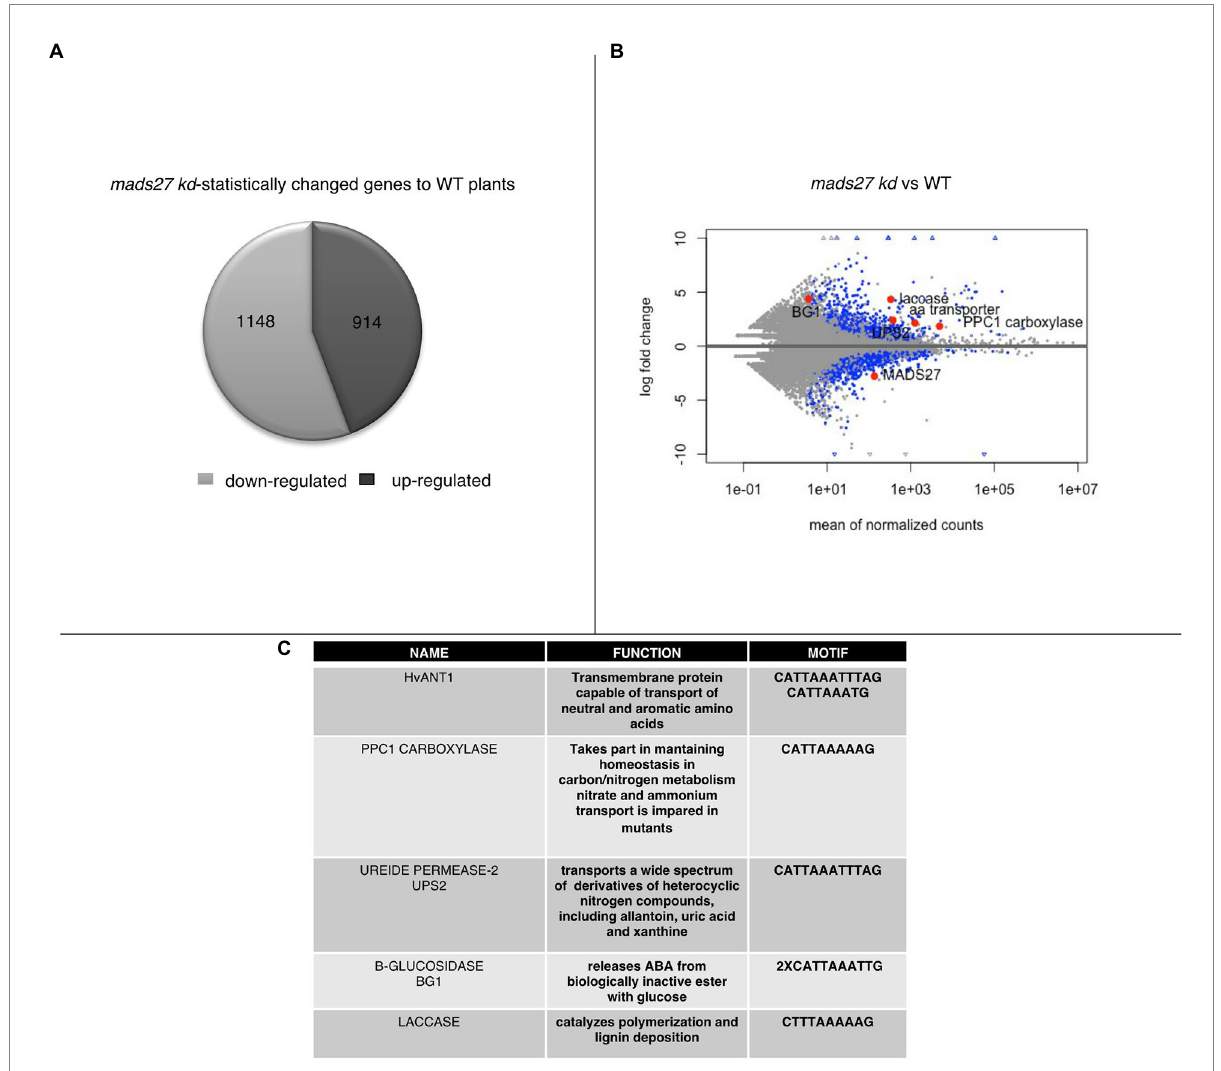
FIGURE 5 Transcriptomic analysis of roots of mads27 kd plants. (A) Pie chart depicting differentially expressed genes in the roots of mads27 kd mutants compared with that of WT roots. A total of 1,148 downregulated genes and 914 upregulated genes were identified. From upregulated group, genes harboring CArG motif in their promoter regions were selected for further analysis. (B) Volcano plot representing the expression level of candidate genes in the roots of mads27 kd mutant depicted in red dots. X -axis shows normalized counts and y -axis represents gene expression fold change. Blue dots in volcano plot represent significantly affected genes based on p value of Bonferroni correction. (C) List of the genes, function, and sequence of motif embedded in their promoters are shown in